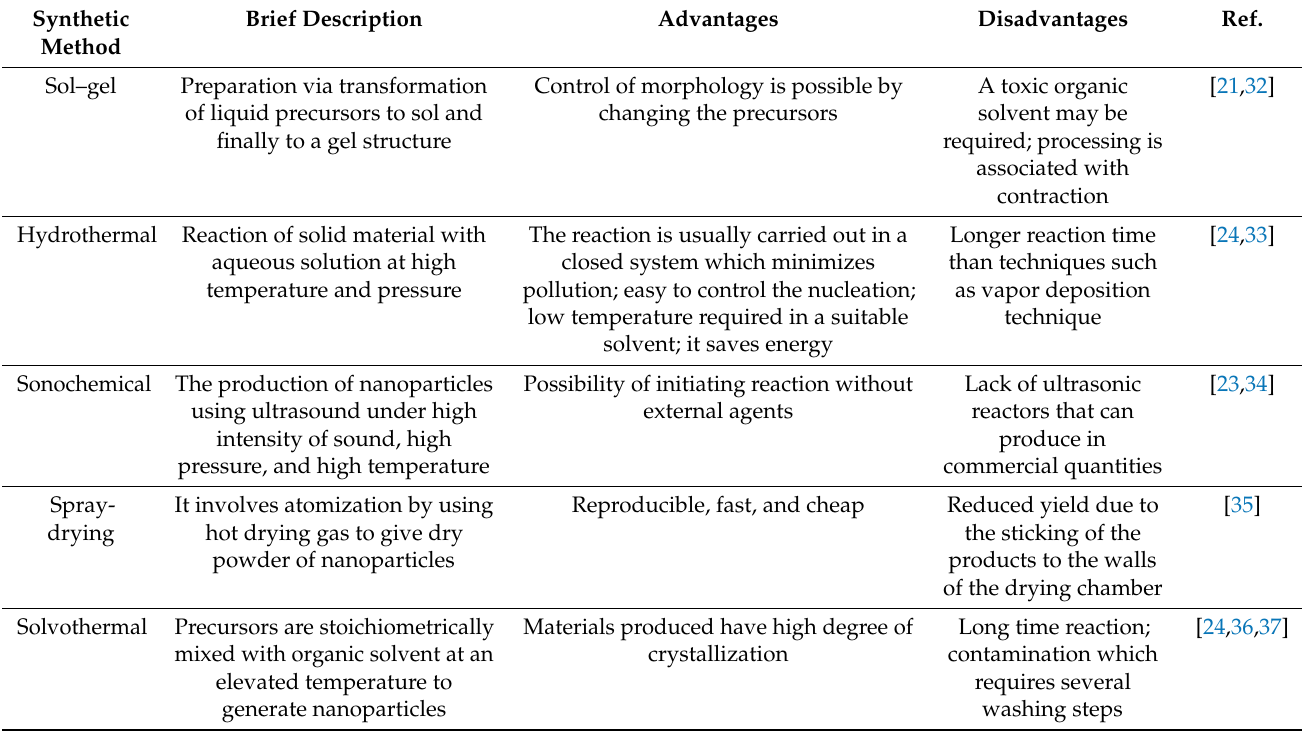
Table 1. Advantages and disadvantages of methods for synthesizing binary oxide nanoparticles.